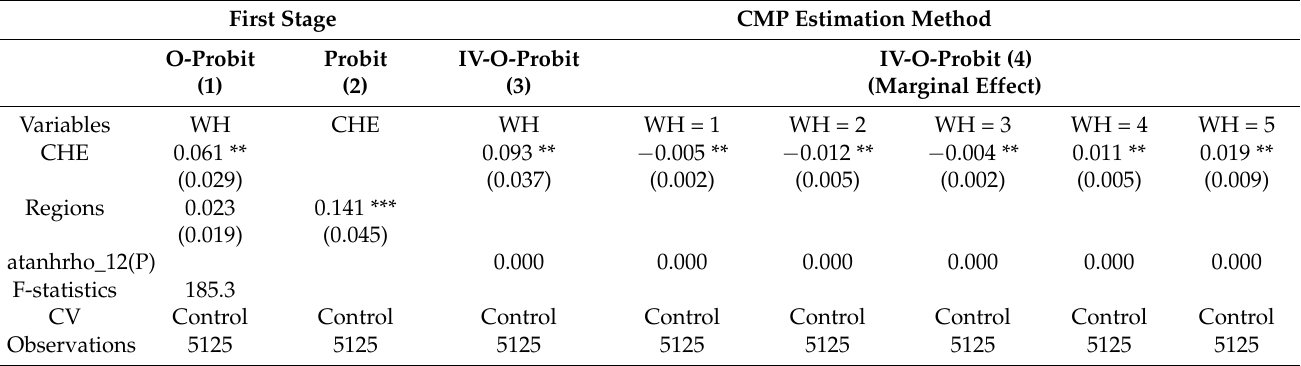
Table 5. The results of IV-O-Probit model for endogenous